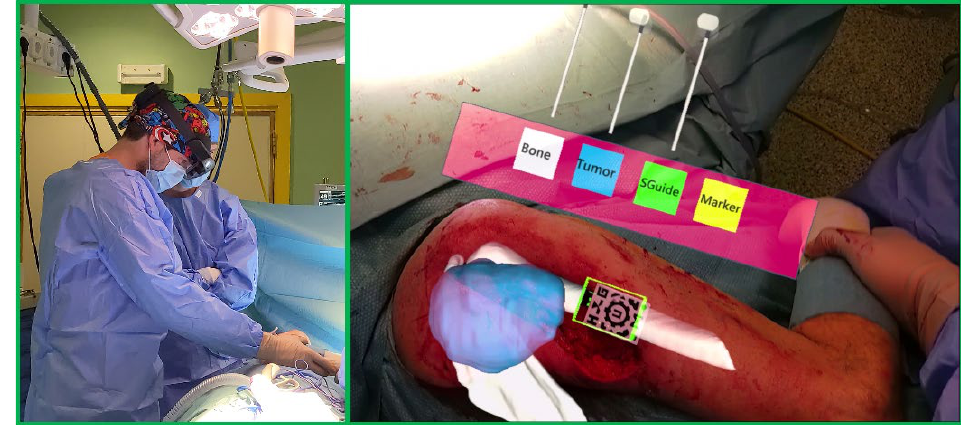
Figure 7. AR visualization on Microsoft HoloLens 2 from surgeon’s perspective during the intervention on patient HL2_Shoulder. The left-hand side of the figure shows an external view of the surgical field.